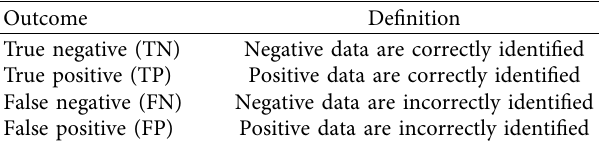
Table 3: Prediction outcome.